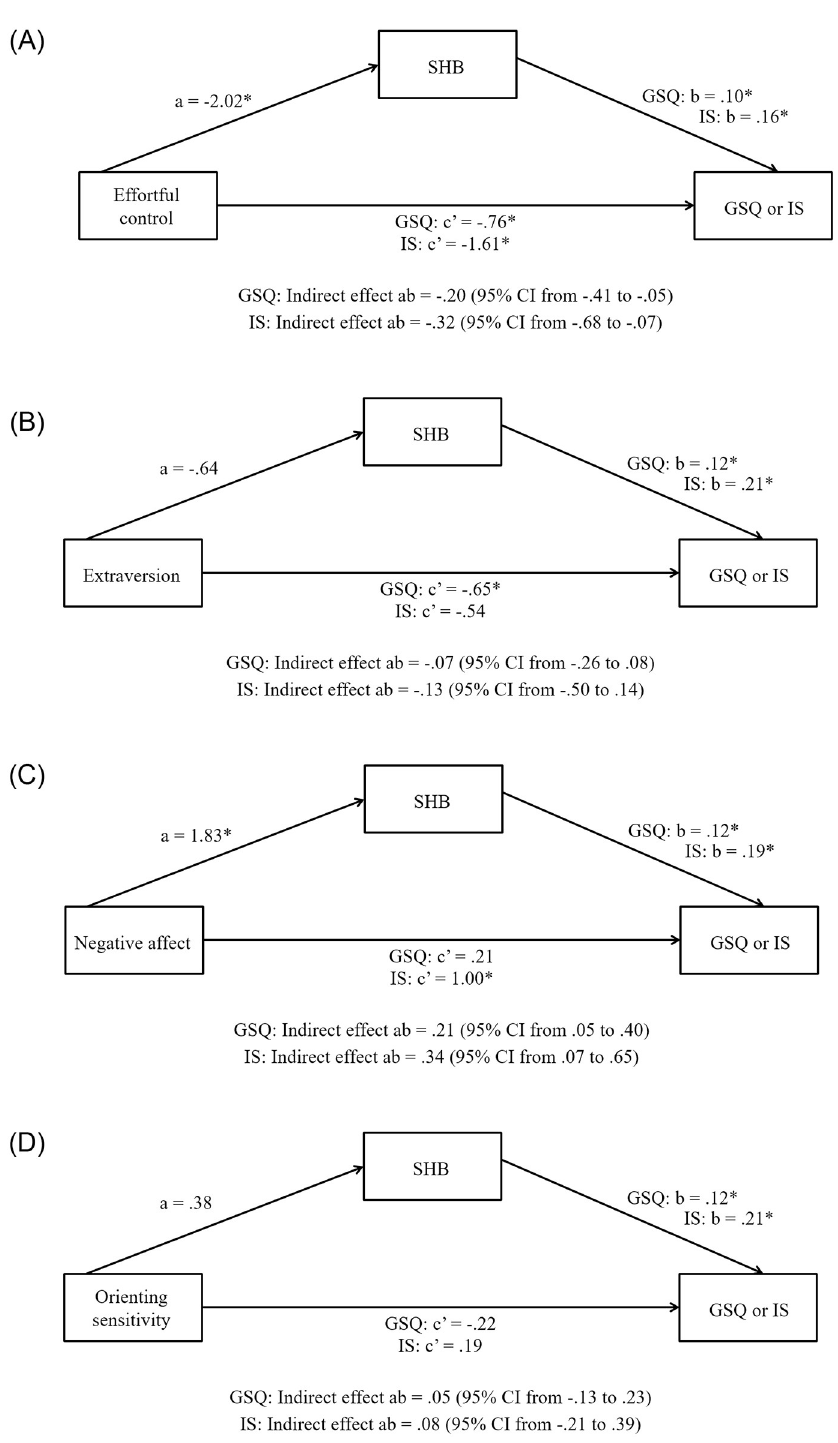
Fig 1. Panel A. Simple mediation analyses: Effortful control. Simple mediation analyses were conducted to identify whether the SHI composite mediated associations between (1) effortful control and PSQI global scores as well as (2) effortful control and ISI scores. Covariates were included in the models as described in the Results section. Significant effects are indicated: � p < .05. Panel B. Simple mediation analyses: Extraversion. Simple mediation analyses were conducted to identify whether the SHI composite mediated associations between (1) extraversion and PSQI global scores and (2) extraversion and ISI scores. Covariates were included in the models as described in the Results section.